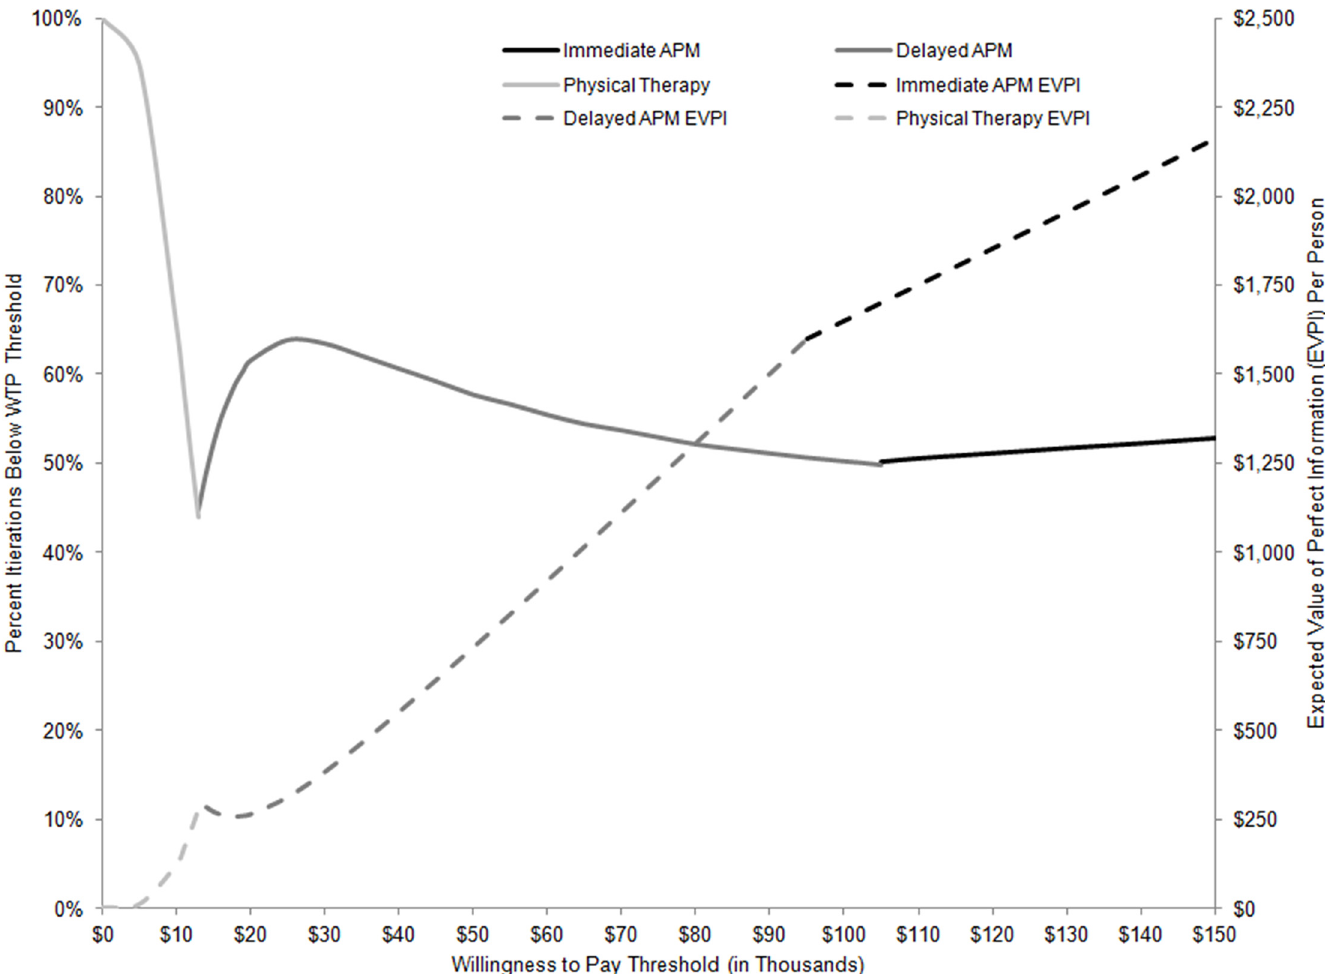
Fig 4. Cost-effectiveness Acceptability Frontier and Expected Value of Perfect Information. Fig 4 contains two categories of reported results. The first is the cost-effectiveness acceptability frontier, described by solid gray and black lines at the top half of the graph. The frontier describes the likelihood that the strategy with highest NMB at any given WTP threshold is cost-effective, where likelihood is defined as a probability on the left-most Y axis. NMB is calculated by subtracting the cost of a treatment strategy from the product of a strategy ’ s effectiveness and a given WTP. The bottom half of the graph describes the EVPI reported for each WTP threshold for the strategy defined as preferred under that threshold. EVPI results are represented by dotted lines in dollars per person by the right-side Y axis. Time costs were not